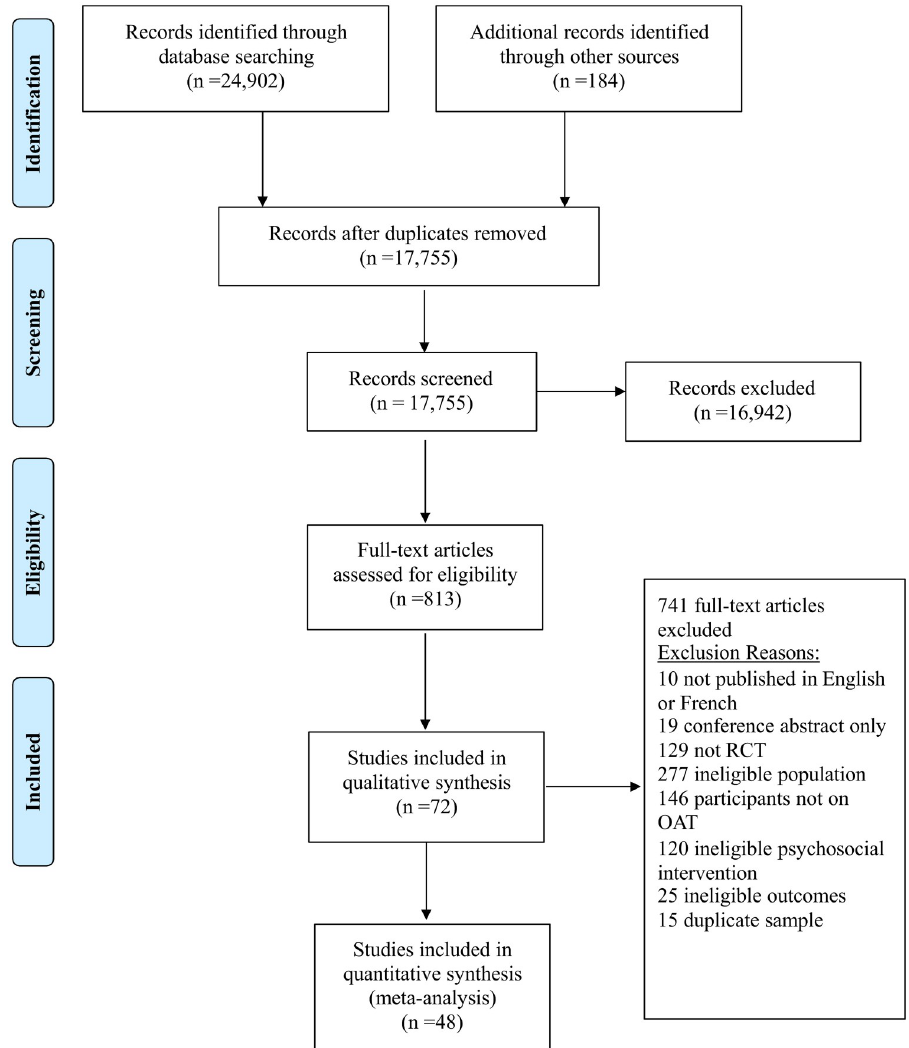
Fig 1. Process of study selection. A flow diagram is shown which depicts the process of study selection.